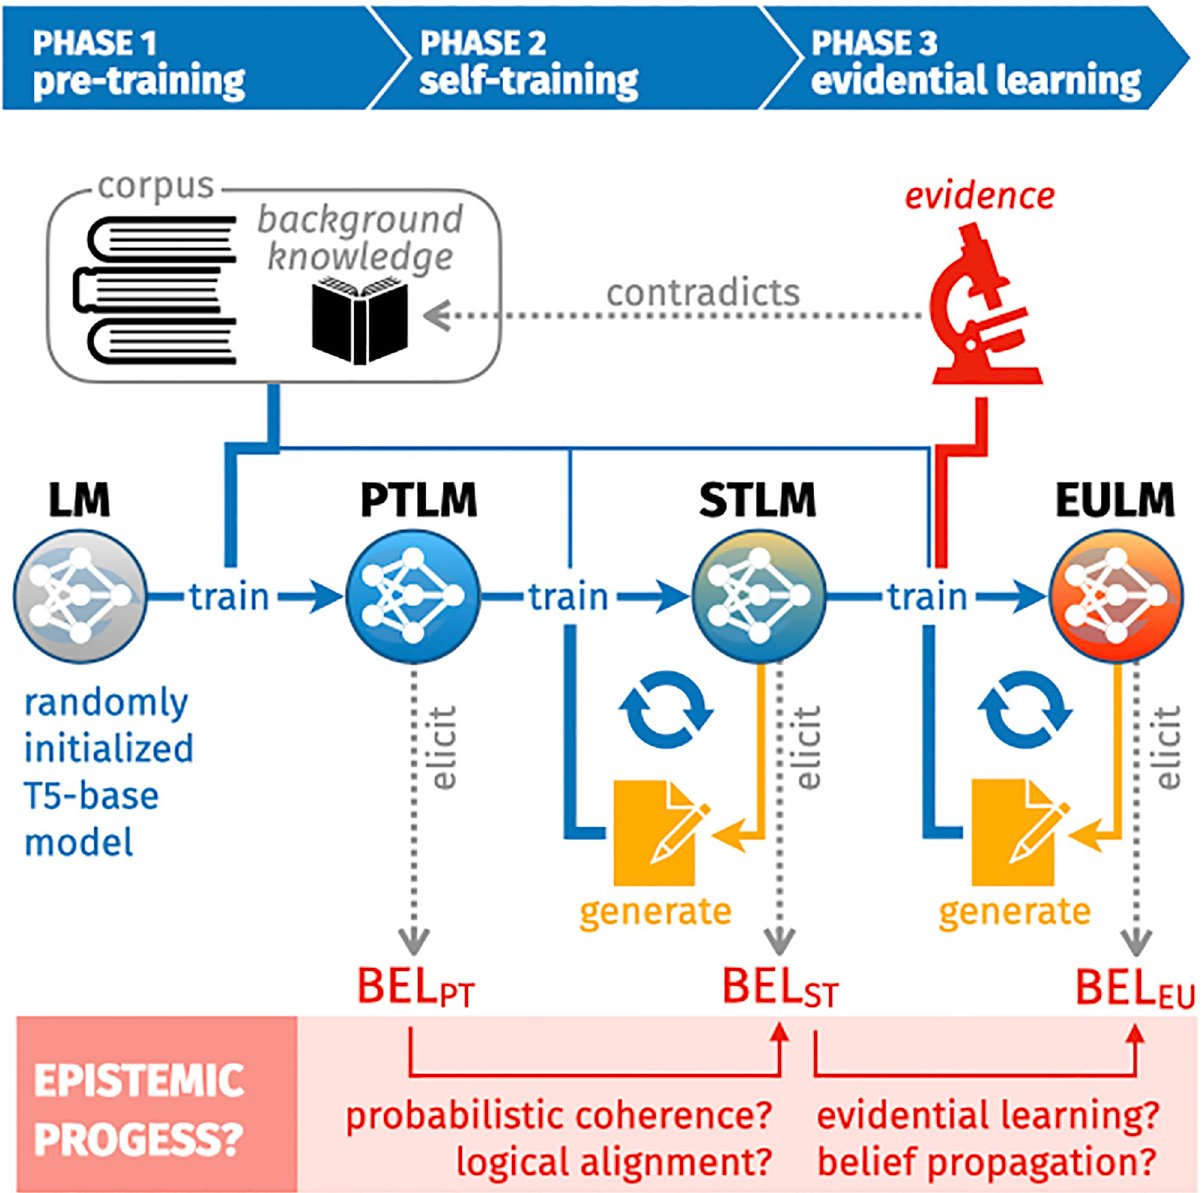
Fig 1. Overall design. A randomly initialized RANKER model (LM) is trained on a synthetic text corpus produced by artificial authors. The accordingly pre-trained RANKER model (PTLM) subsequently trains on auto-generated texts, yielding a self-trained RANKER (STLM), which is eventually exposed to novel evidence during training, resulting in an evidentially updated model